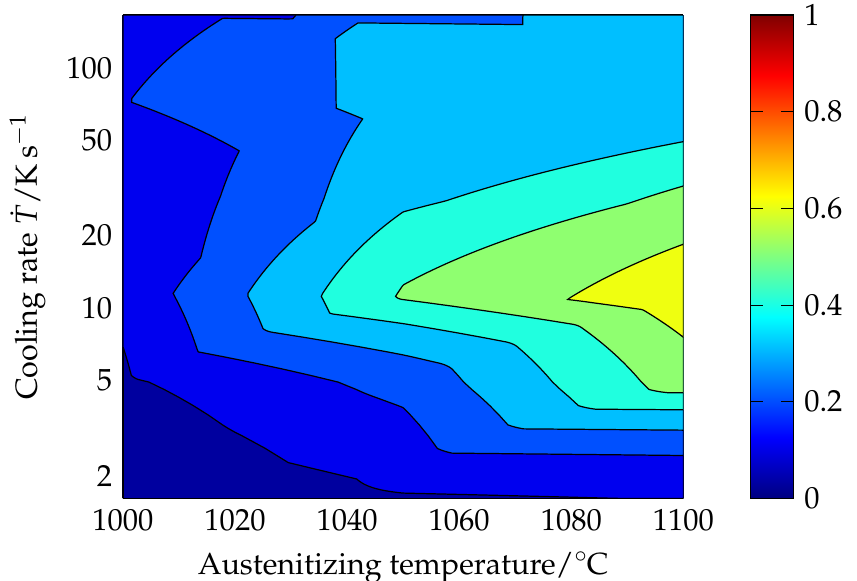
Figure 26. Product of normalized hardness and pitting corrosion potential (equally weighted) as a function of the cooling rate (logarithmic scale) and the austenitizing temperature to determine an optimum process window with high corrosion resistance and hardness.